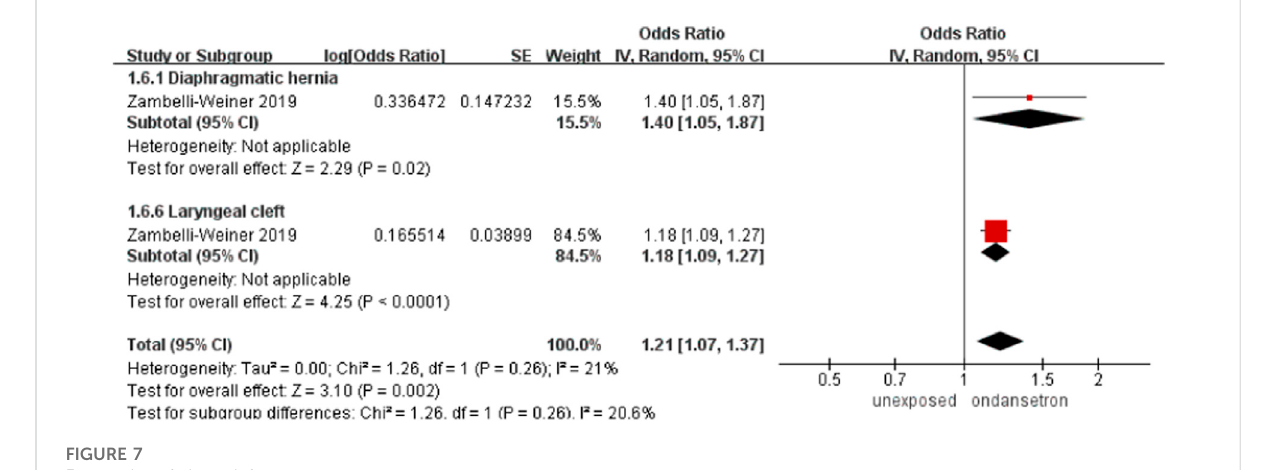
FIGURE 7 Forest plot of chest defects.